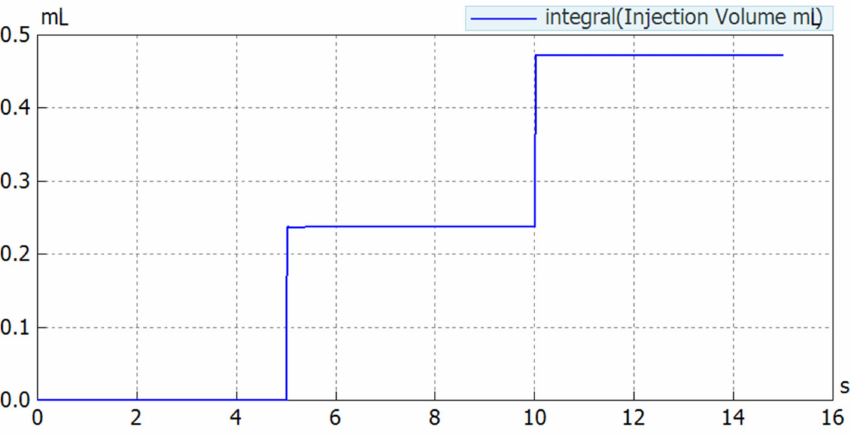
Figure 12. Simulation result marking flow quantity for 2 consecutive